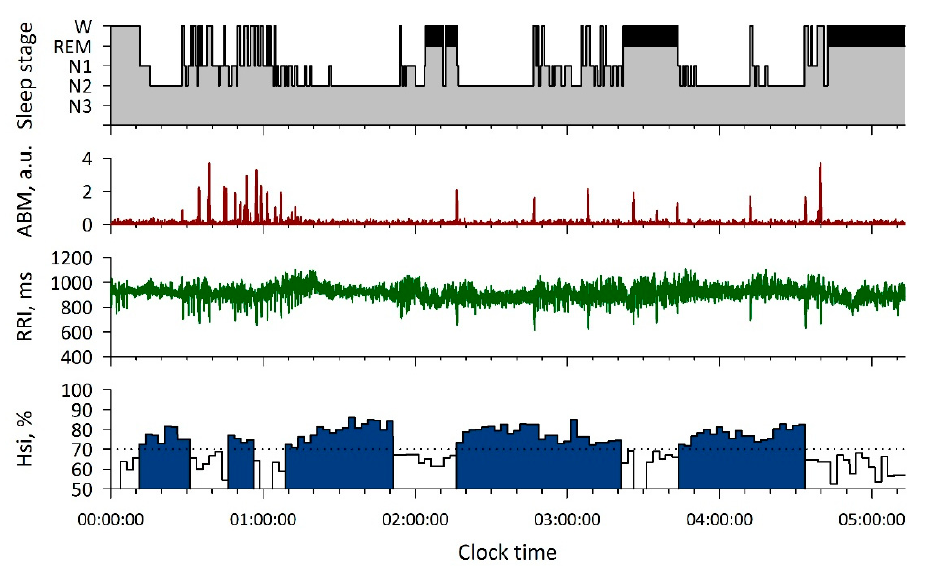
Figure 3. All-night hypnogram and Hsi in a healthy female subject. From the top, hypnogram, ABM, R-R interval, and Hsi. While Hsi is below 70% during wake (W) and REM sleep (marked with black in hypnogram), it exceeds 70% in synchrony with the appearance of NREM sleep (N1–N3).